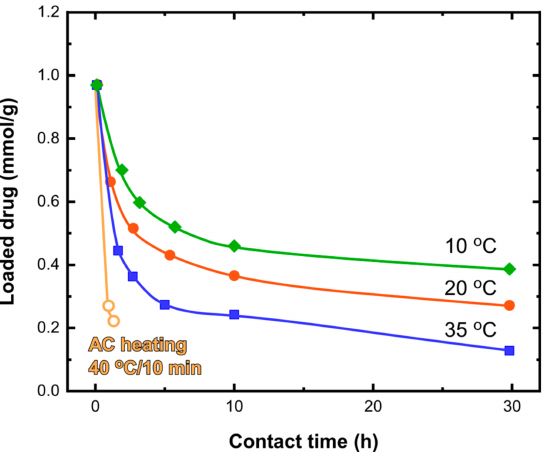
Figure 7. Drug release evolution for drug-loaded MGT-35 in PBS solution adjusted to pH 7.4 for various temperatures and corresponding curves for keeping the dispersion at 40 ◦ C by applying AC magnetic